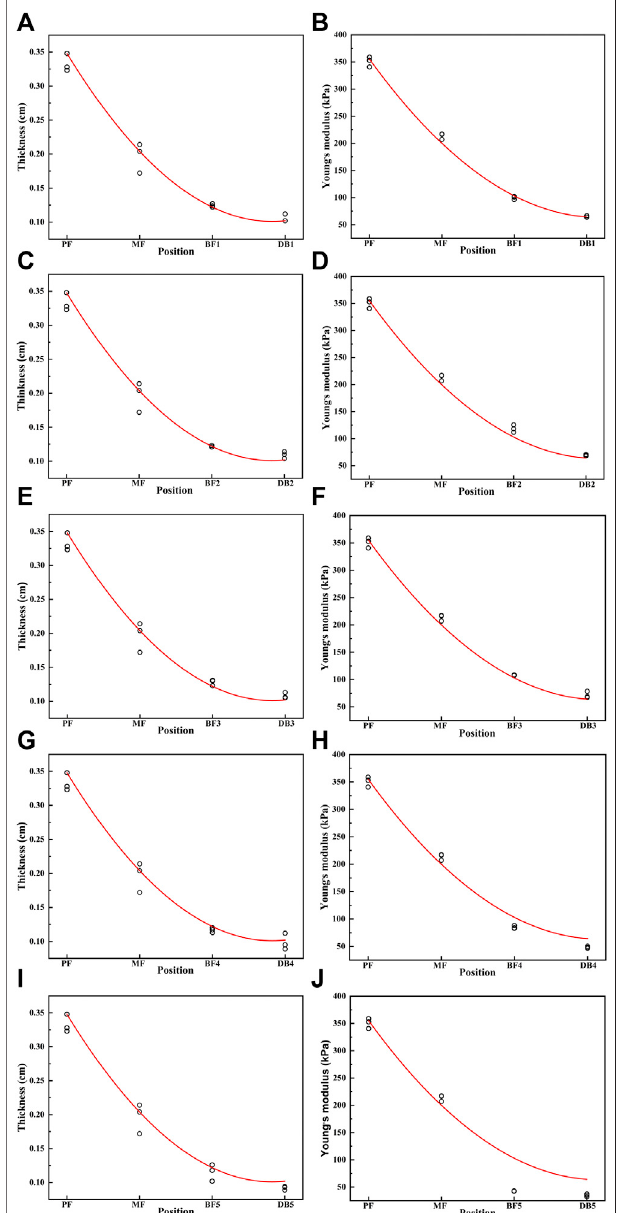
FIGURE 5 | ThecurveofthethicknessandYoung ’ smodulusoftheplantar fasciafromthecalcaneustothe fi vedistalbranchesinfoot#1: (A) thicknessofthe fi rst branch, (B) Young ’ s modulus of the fi rst branch, (C) thickness of the second branch, (D) Young ’ smodulusofthesecondbranch, (E) thicknessofthethird branch, (F) Young ’ smodulusofthethirdbranch, (G) thicknessoftheforthbranch, (H) Young ’ s modulus of the forth branch, (I) thickness of the fi fth branch, and (J) Young ’ s modulus of the fi fth